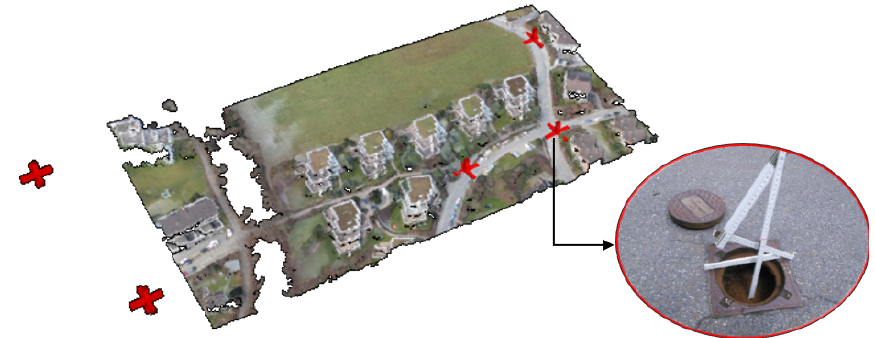
Figure 3. Left: locations of the georeferencing points used in the study (red crosses). While the left-most points are outside of the area of study, they were covered by UAV images. Right: measurement of vertical distance between GCP access cover and actual GCP point.